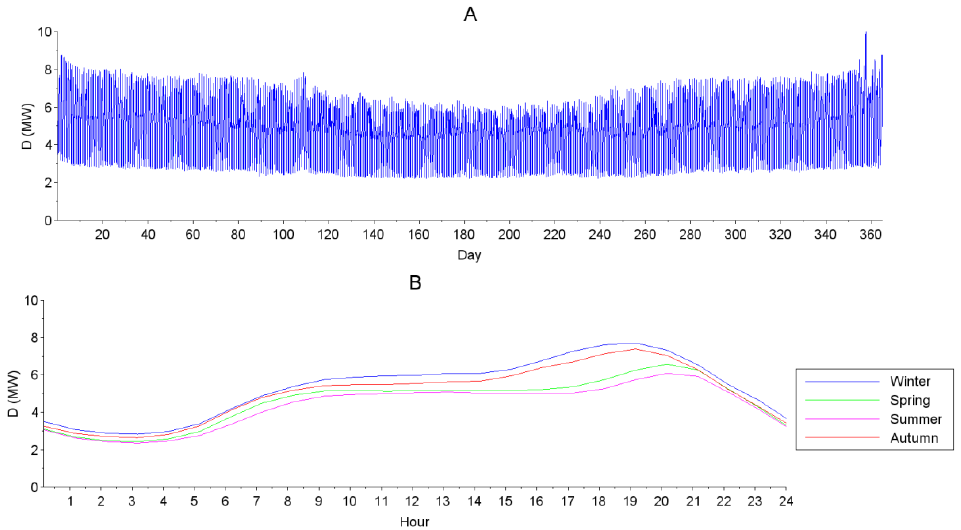
Figure 1. Distribution of power demand ( D ): ( A ) during the year, and ( B ) average during the day in particular seasons of the year.